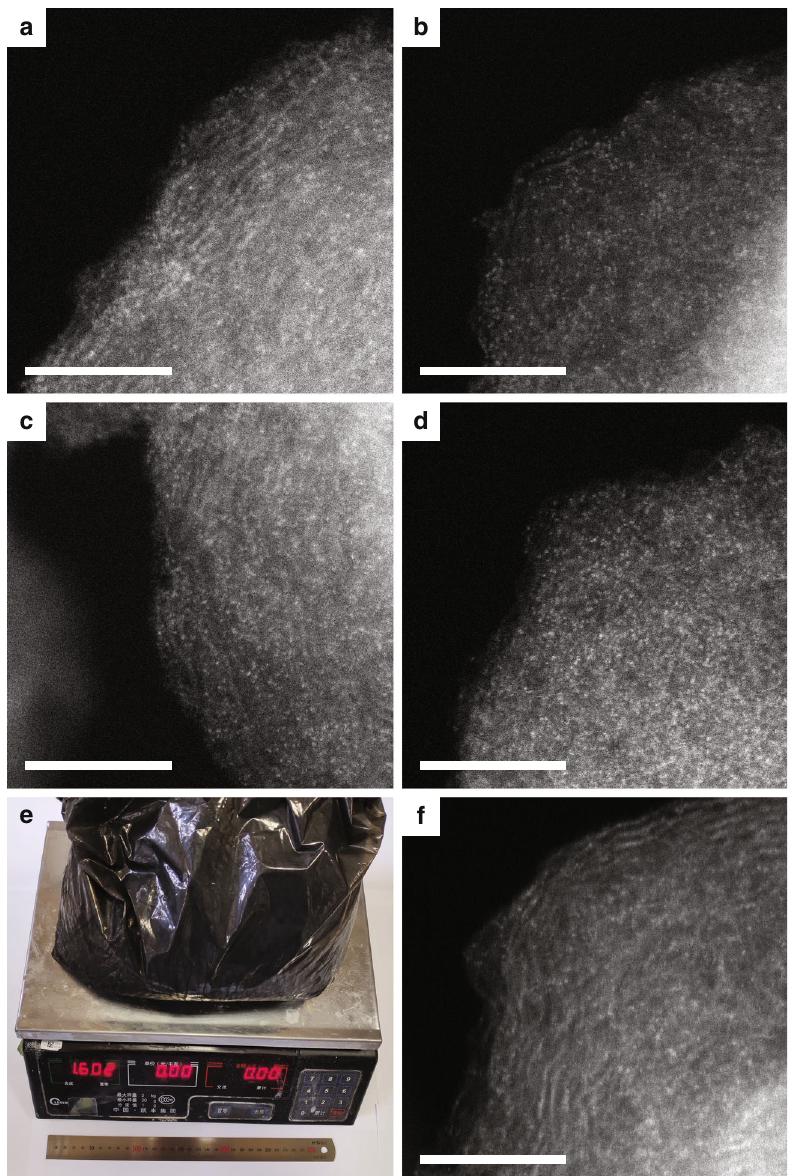
Fig. 5 Characterization and large-scale synthesis of Ni catalysts with different loadings. a HAADF-STEM image for Ni-SAC with 2.5 wt.% Ni loading. b HAADF-STEM image for Ni-SAC with 3.4 wt.% Ni loading. c HAADF-STEM image for Ni-SAC with 4.5 wt.% Ni loading. d HAADF-STEM image for Ni- SAC with 5.3 wt.% Ni loading. Scale bar: 5 nm. e Photograph for Ni-SAC-2.5 synthesized in large scale. f HAADF-STEM image for Ni-SAC-2.5 synthesized in large scale. Scale bar: 5